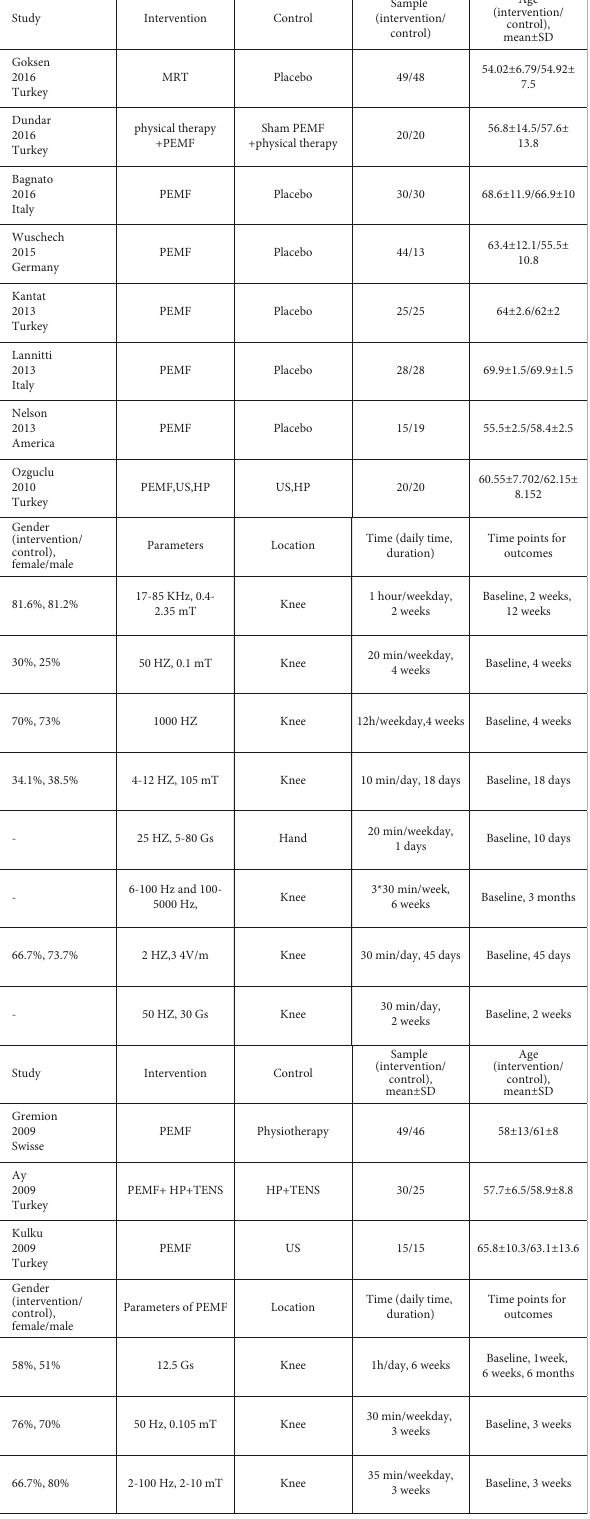
Figure 3: Characteristic of selected records in this meta-analysis. Abbreviations: HP: hot pack, TENS: transcutaneouselectrical nerve stimulation, US: ultrasound, and MRT: magnetic resonance